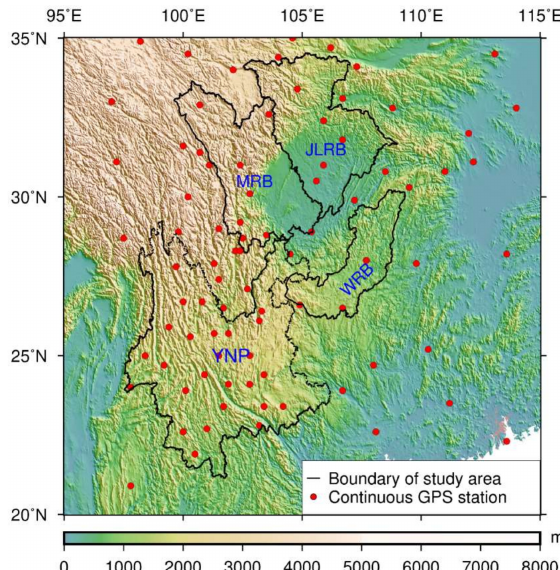
Figure 1. The four studied regions in Southwest China: The abbreviations YNP, MRB, JLRB, and WRB in blue indicate Yunnan Province, Min River Basin, Jialing River Basin, and Wu River Basin, respectively. The red dots represent the distribution of permanent Global Positioning System (GPS) stations, the black lines are boundaries of the four regions, and the background represents the digital elevation model (DEM) information of Southwest